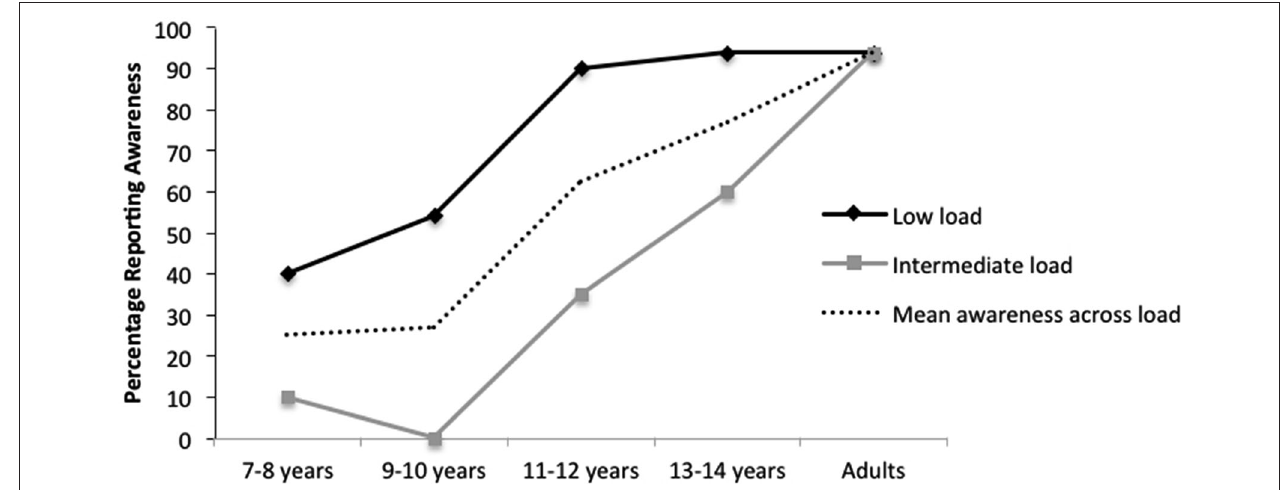
FIGURE 4 | Percentage of reported awareness of a peripheral critical stimulus (peripheral target) as a function of perceptual load (low vs. intermediate) and age, N = 192, in Experiment 2 .